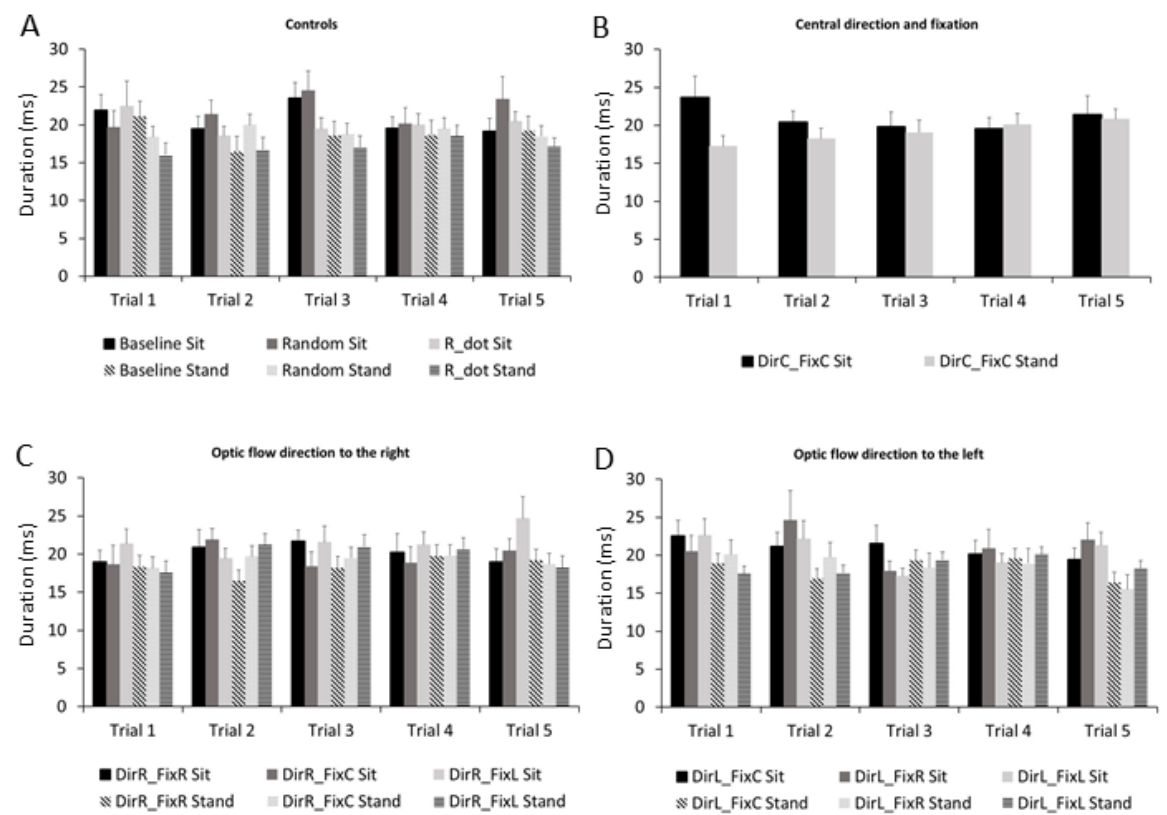
Figure 5. Frequency histograms of microsaccade durations in all stimuli across trials in both sitting and standing conditions. ( A ) Controls: Baseline, R_dot, Random. ( B ) Central direction and fixation: DirC-FixC. ( C ) Optic flow direction to the right: DirR-FixR, DirR-FixC, DirR-FixL. ( D ) Optic flow direction to the left: DirL-FixR, DirL-FixC, DirL-FixL. Data are reported as mean ± SE. Conventions are as in Figure 1.